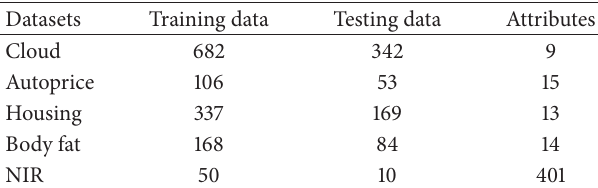
Table 8: Specifications of binary classification cases.